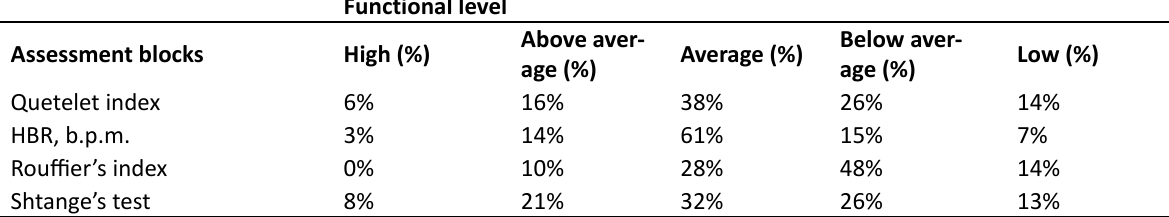
Table 2. Distribution of first year students by physical condition indicators Functional